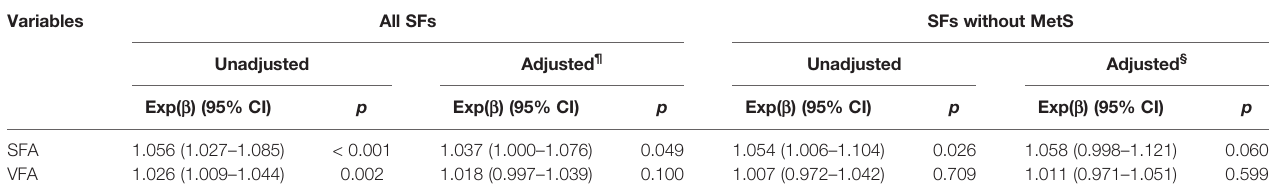
TABLE 4 | The relationship between SFA, VFA, and the number of stone episodes in all SFs and those without MetS.